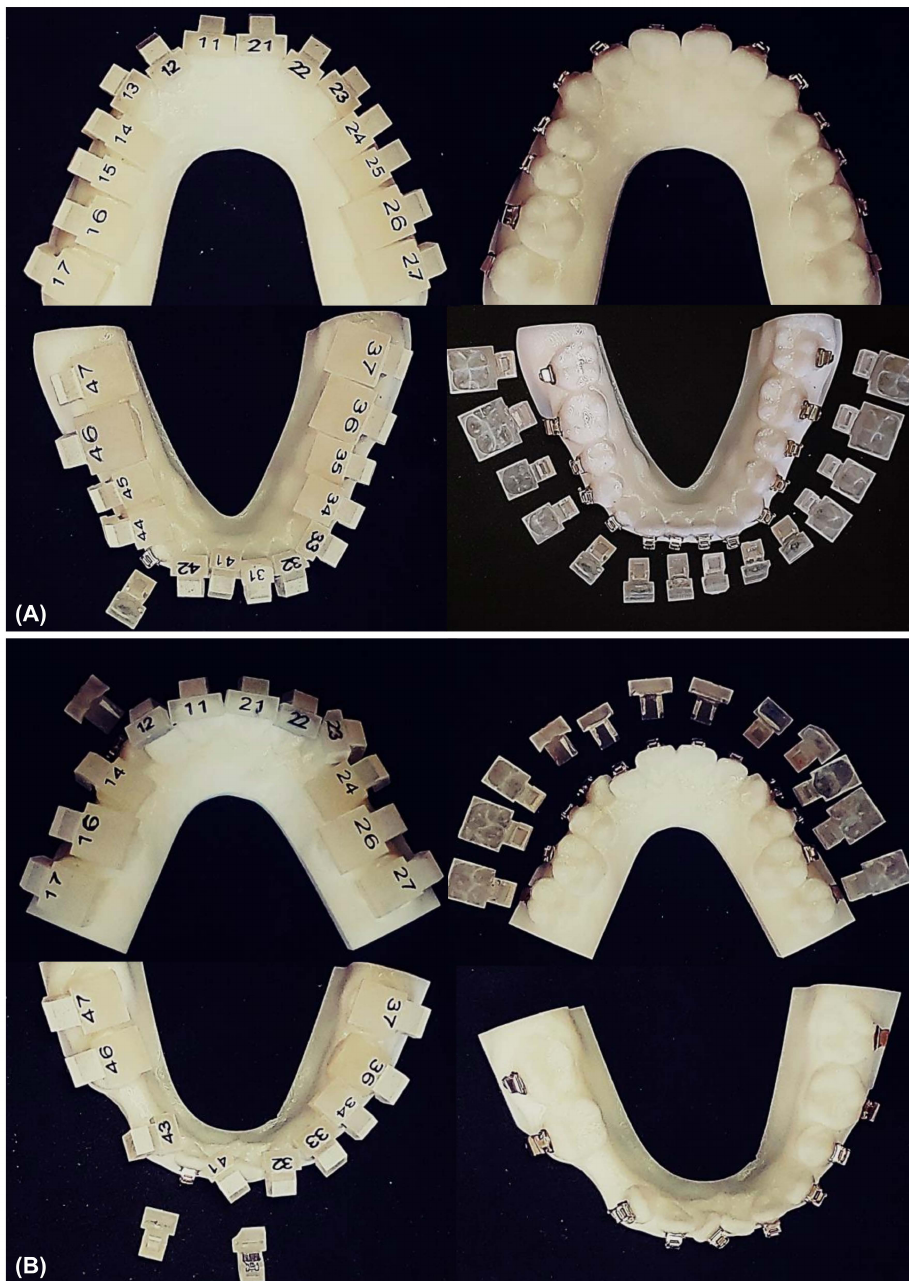
Figure 4. One-body transfer jig fabricated by CAD/CAM technology with rapid prototyping (RP) models. ( A ) Brackets transferred to the noncrowded model by indirect bonding procedure using the jig system, ( B ) Brackets transferred to the crowded model by indirect bonding procedure using the jig